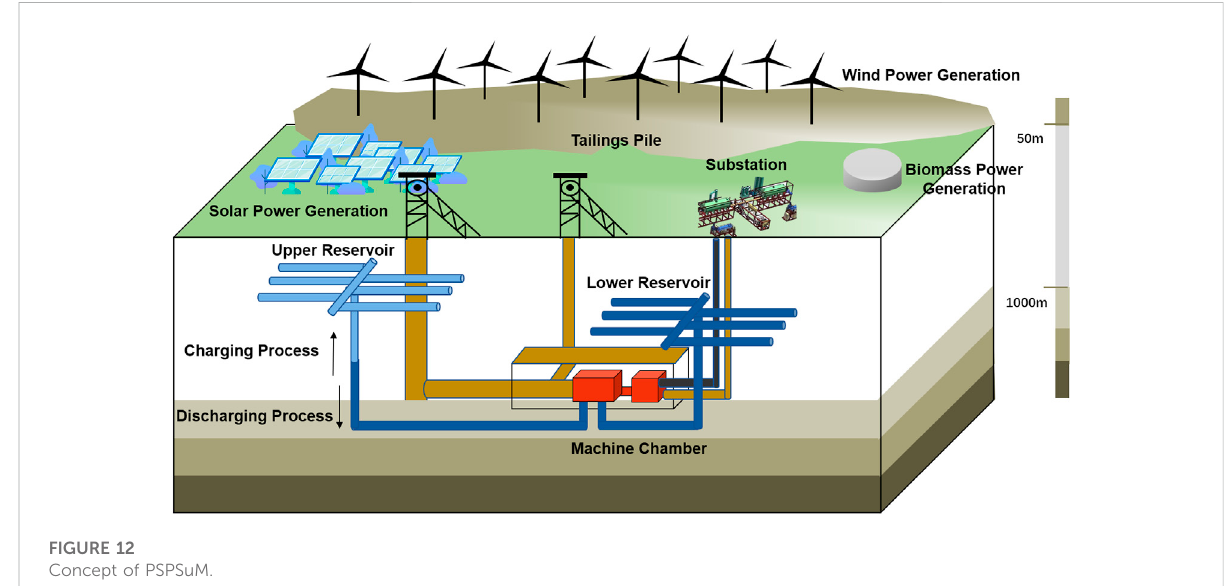
FIGURE 12 Concept of